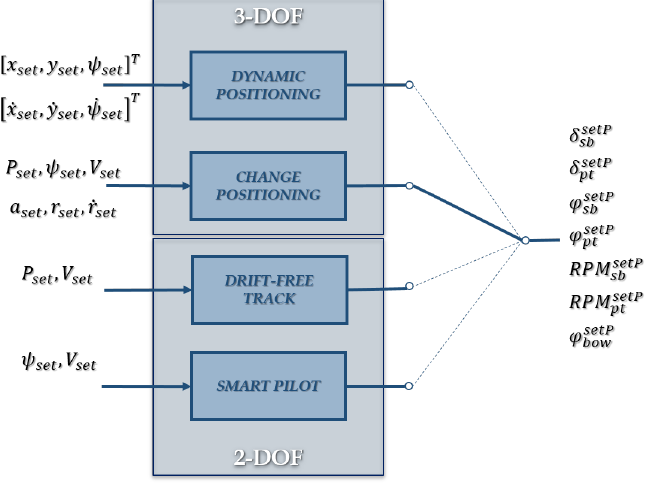
Figure 1. Controller